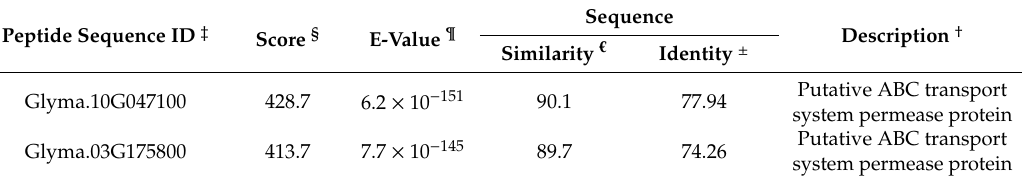
Table 1. AtALS3 orthologs in